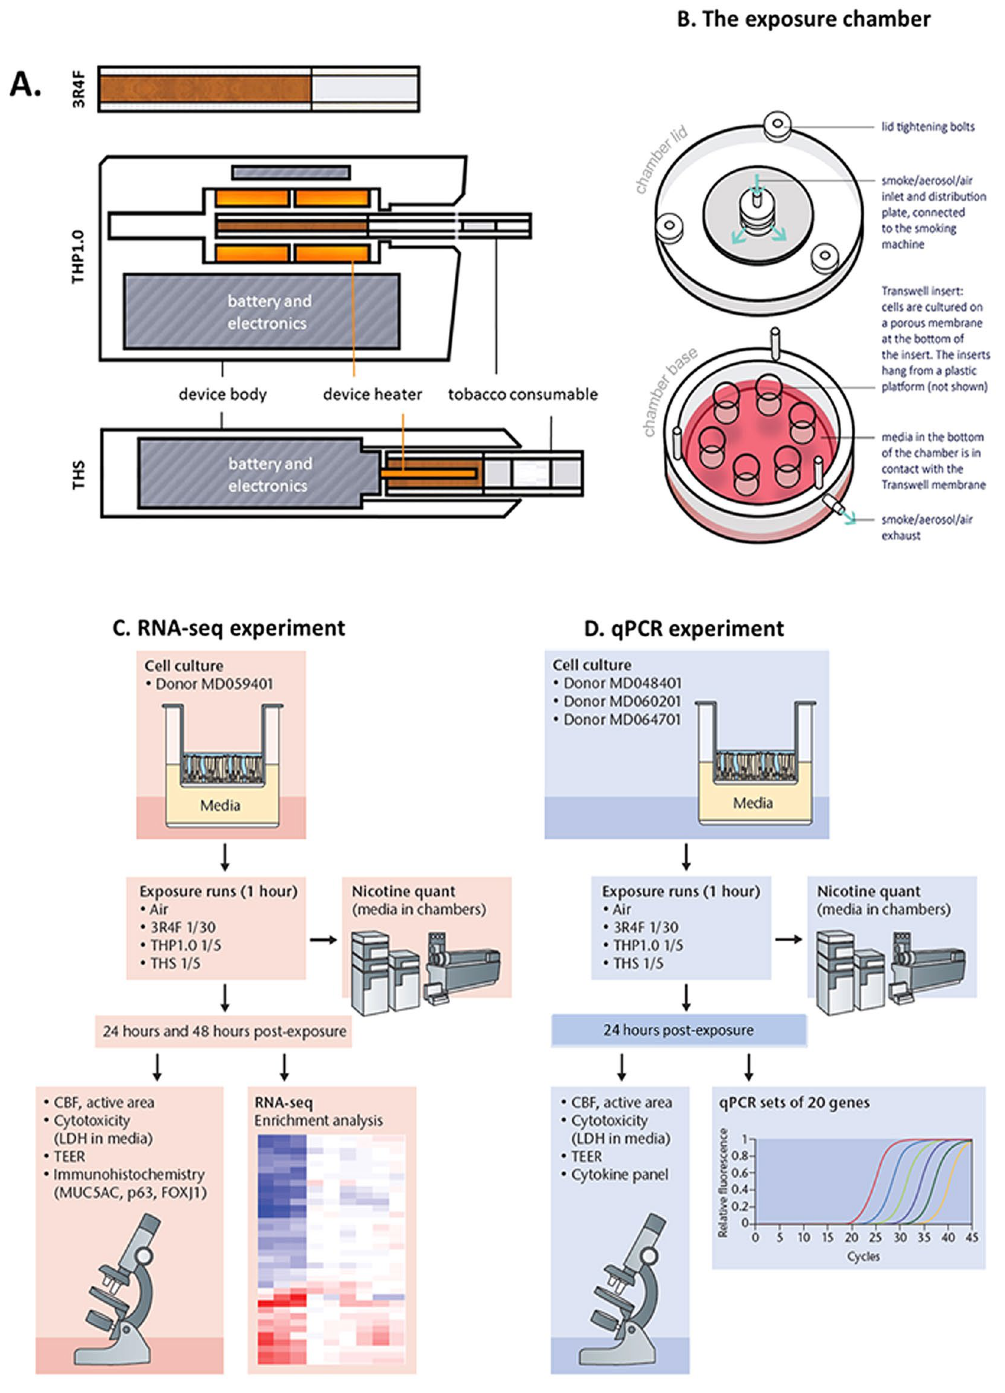
Figure 1. Test product schematics and experimental design summary. ( A ) Cross section schematic representation of the 3 test products used in this study: 3R4F reference combustible cigarette; THP1.0 having a slim size tobacco consumable inserted in the heating device with the peripheral heating components and THS having a king size tobacco consumable with a centrally positioned heating blade. ( B ) Aerosol exposure chambers with the cell inserts position (Figure adapted from Haswell et al . 13 ). ( C ) RNA-seq experimental design. MucilAir TM (donor MD059401) reconstituted airway tissues were exposed to aerosols from 3R4F, THP1.0, THS and to air at the indicated dilutions (Figure adapted from Haswell et al . 13 ). The media in the exposure chambers were collected for nicotine quantification at the end of the exposure. Following 24 and 48 hrs post-exposure, MucilAir TM tissues were assessed for functional endpoints and RNA isolated for RNA-seq. A minimum of 3 independent repeats were conducted with 3 cell inserts per treatment. ( D ) Validation of results in multiple MucilAir TM donors by qPCR (Figure adapted from Haswell et al . 13 ). Three different donors (MD048401, MD060201, MD064701) were exposed to aerosols of 3R4F,